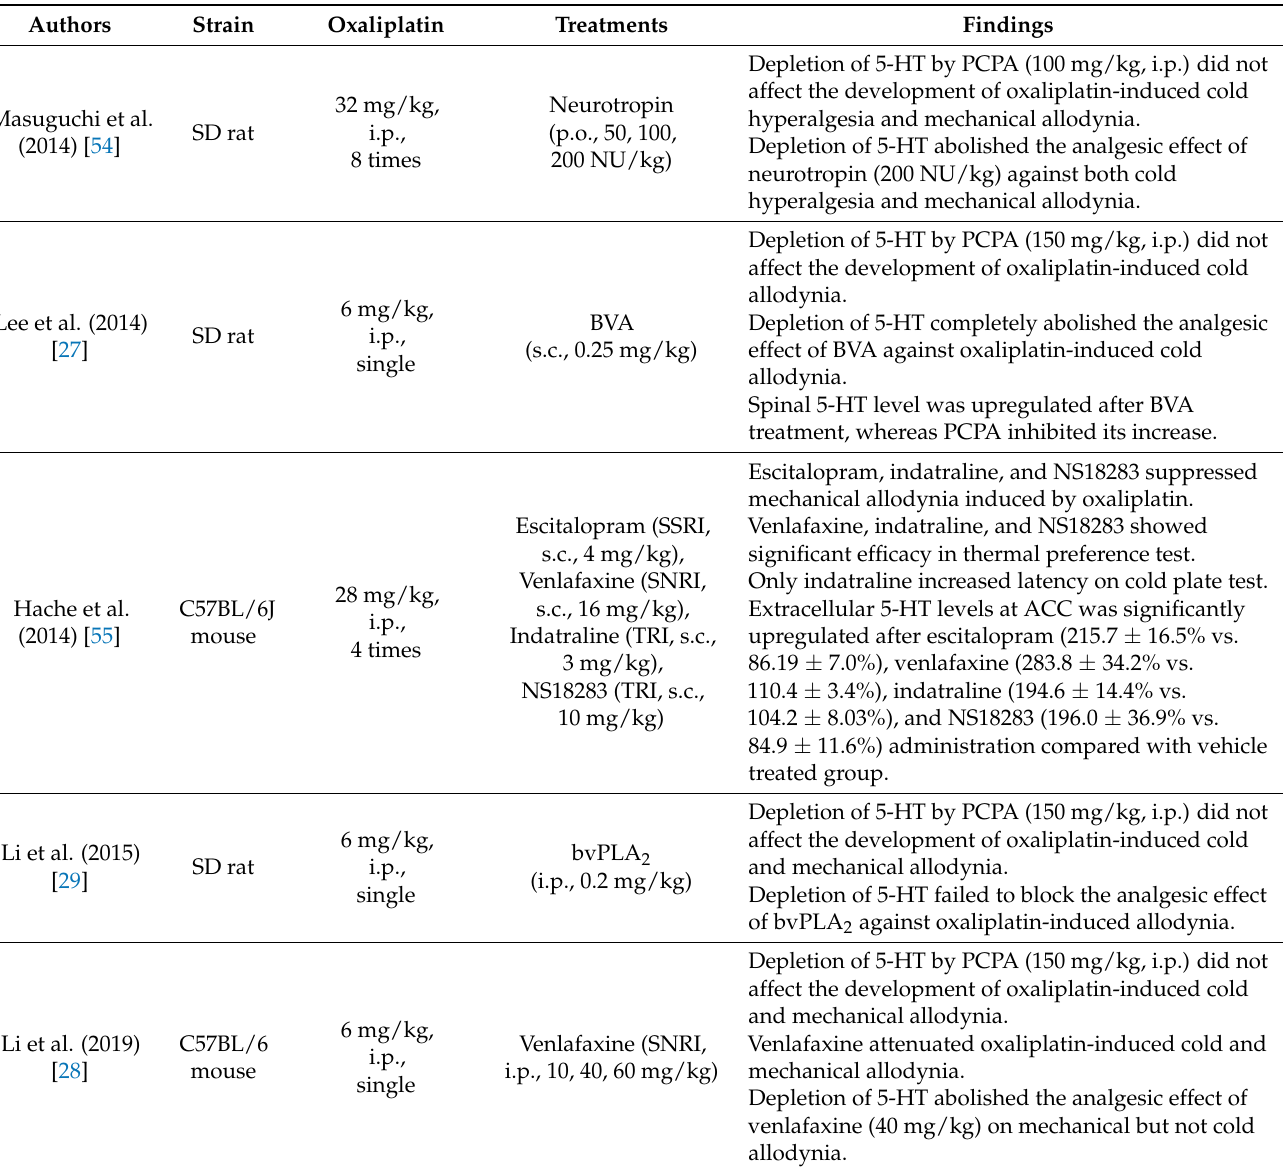
Table 1. Involvement of 5-HT in oxaliplatin-induced neuropathic